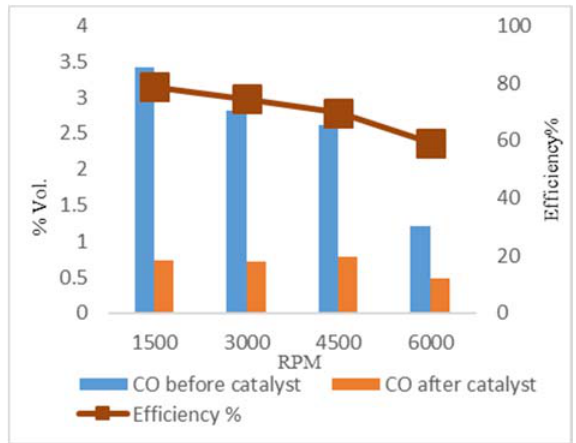
Figure 9. Conversion of CO with 8 wt.% ZrO 2 ‐ Co 3 O 4 /TiO 2 .